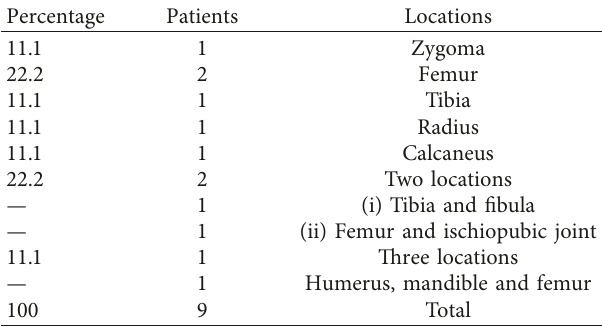
Table 1: Locations of involvement.